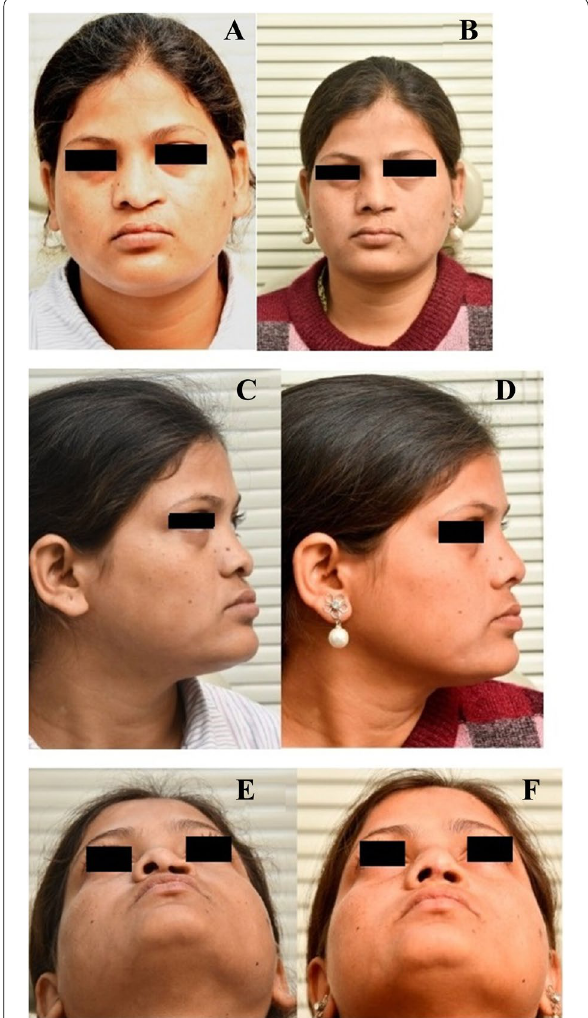
Fig. 5 Comparative pre- and post-operative pictures at 2 years follow-up. A Pre-operative frontal view. B Postoperative frontal view. C Pre-operative left lateral view. D Post operative left lateral view. E Pre-operative basal view. F Postoperative basal